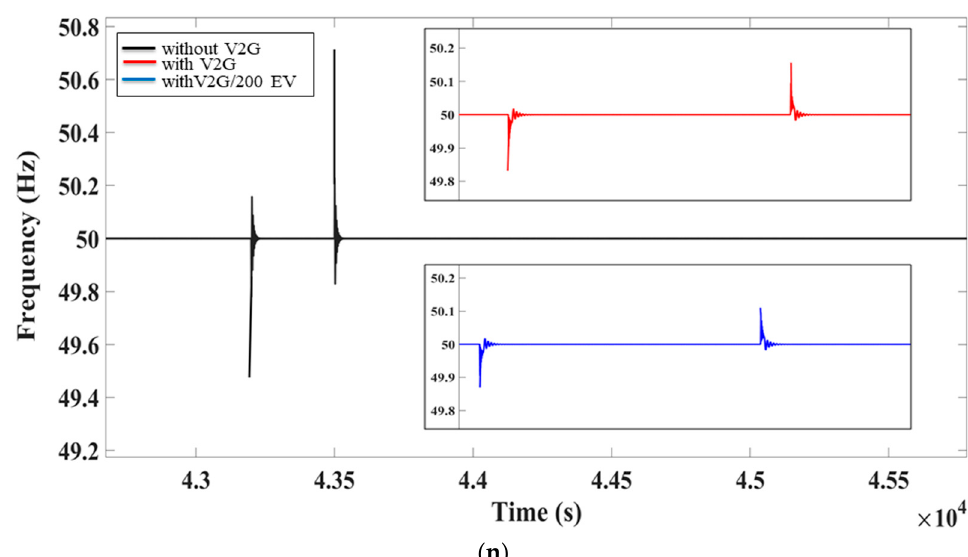
( n ) Figure 7. Reduced PV Farm generation: ( a ) solar irradiation, ( b ) apparent power, ( c ) total power generation, ( d ) load data for case 1, ( e ) regulation data for case 1, ( f ) regulation data for case 2, ( g ) regulation data for case 3, ( h ) charge data for case 1, ( i ) charge data for case 2, ( j ) charge data for case 3, ( k ) SOC car profile for case 1, ( l ) SOC car profile 1 for case 2, ( m ) SOC car profile for case 3, and ( n ) frequency regulation in 3 different cases.